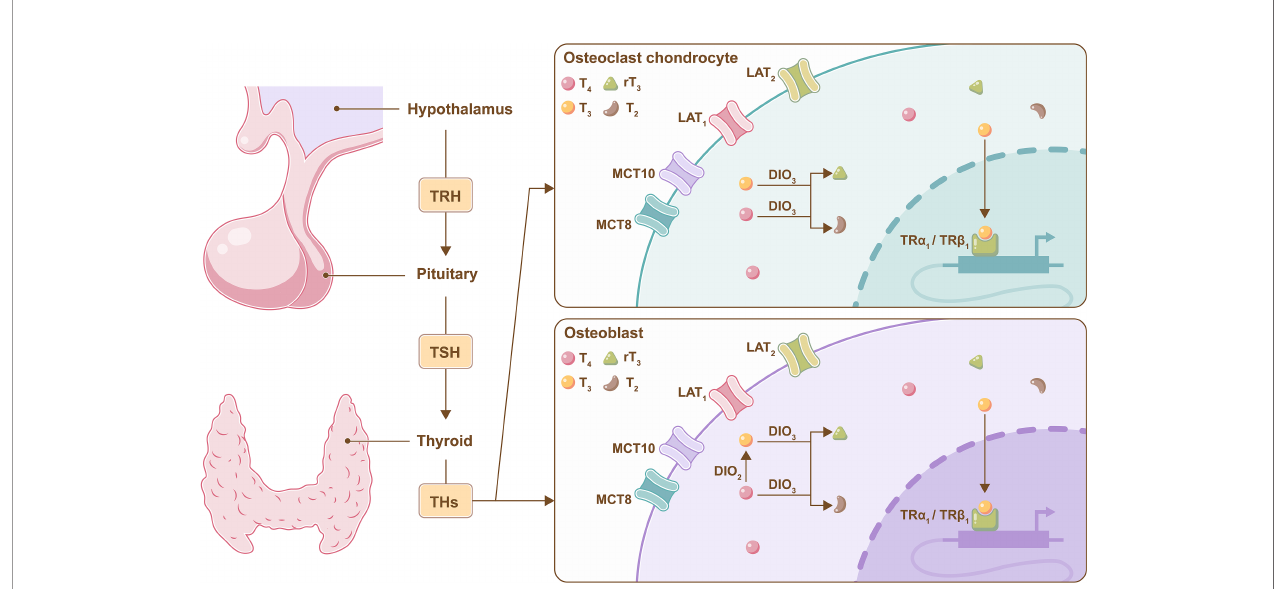
FIGURE 2 | Metabolism of THs in bone cells. A brief illustration of the negative feedback regulation of TH mediated by the hypothalamus pituitary-thyroid axis, and DIO2 converts T4 to bioactive T3 in osteoblasts, and DIO3 converts both T3 and T4 to T2 and rT3 in osteoclasts, chondrocytes and